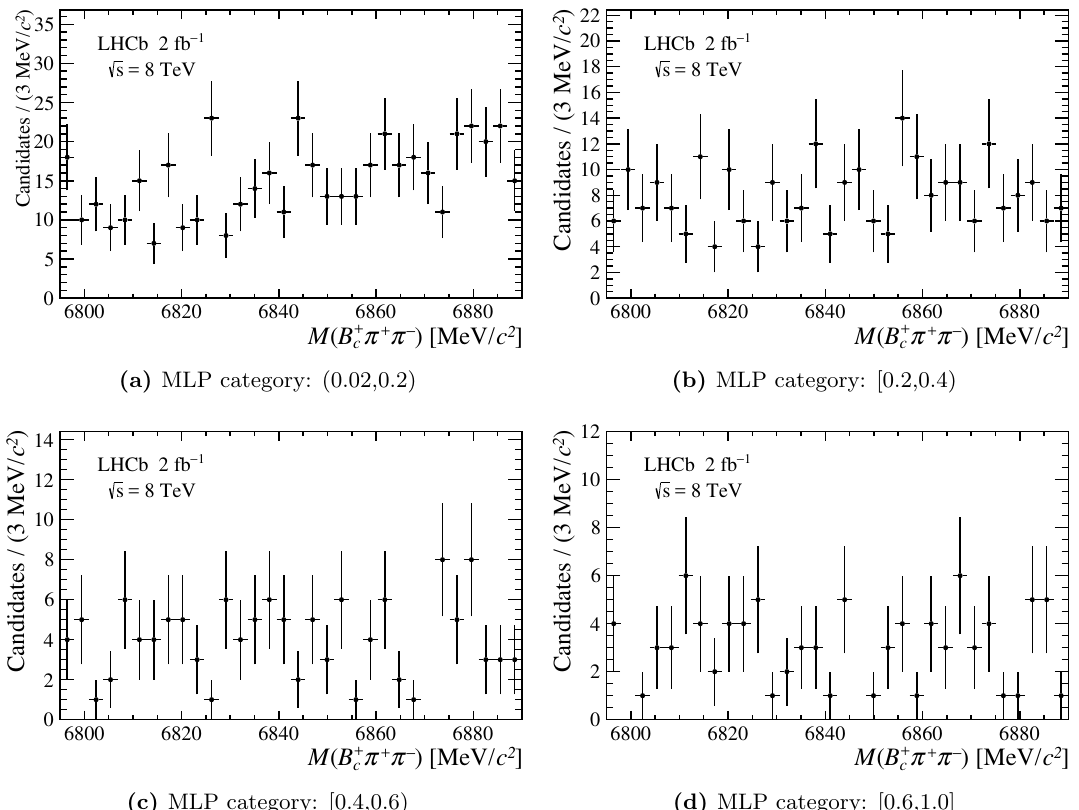
(cid:25) + (cid:25) (cid:0) candidates in the range [6795 ; 6890] MeV =c 2 c